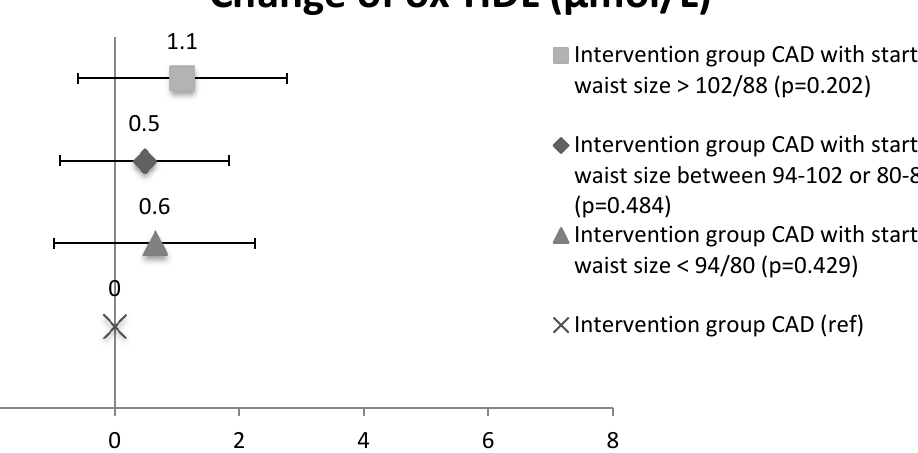
Figure 5. Change of oxidized HDL lipids in CAD waist-circumference subgroups. Mean and CI .